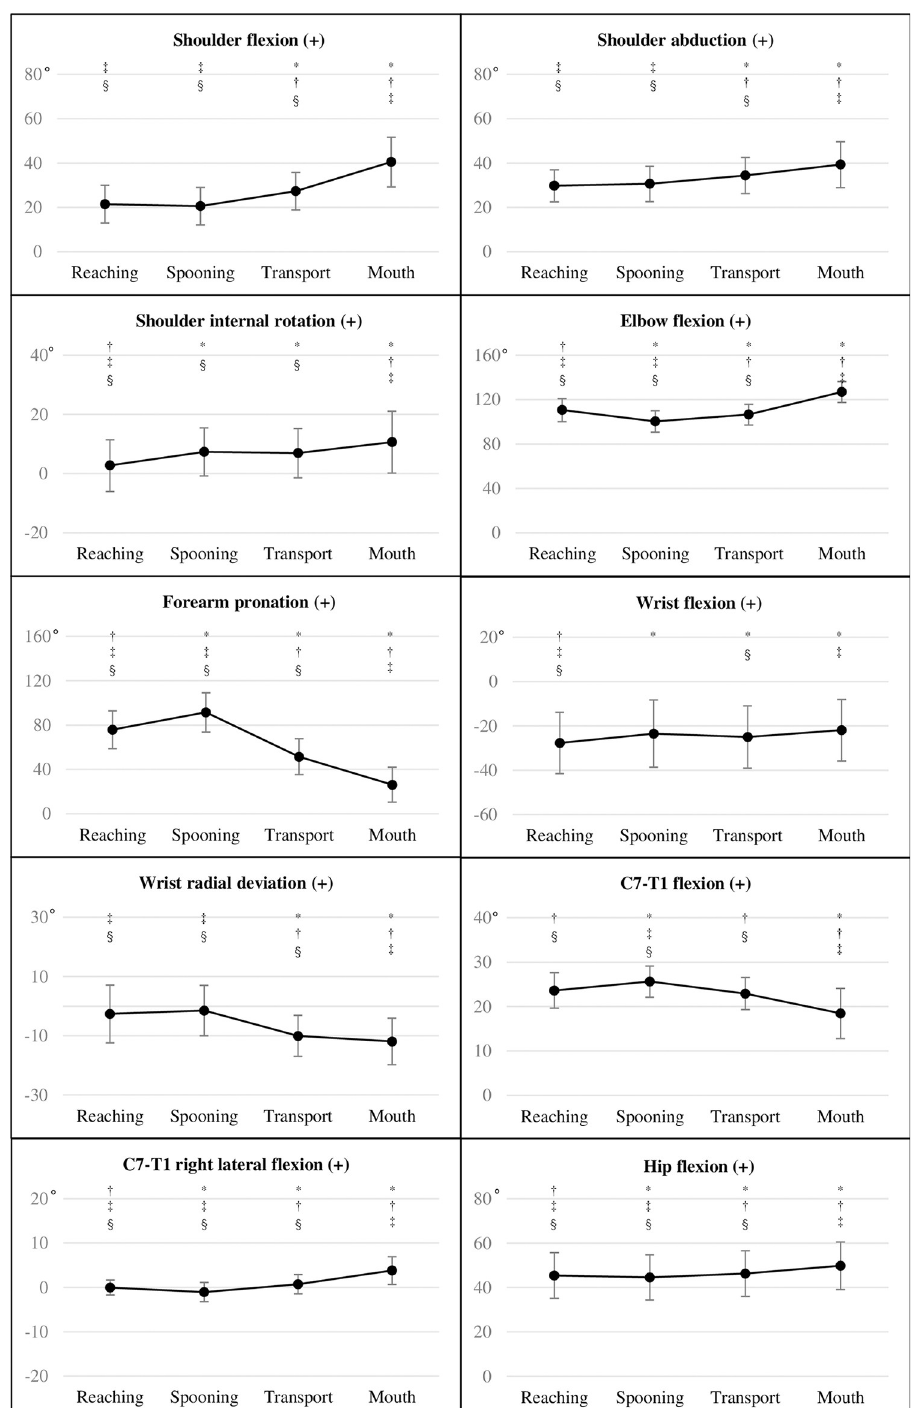
Fig 1. Mean angles in each phase with Bonferroni correction. Eating phases are shown on the horizontal axis. � , significant difference (p < 0.008) compared to the reaching phase; † , significant difference (p < 0.008) compared to the spooning phase; ‡ , significant difference (p < 0.008) compared to the transport phase; § , significant difference (p < 0.008) compared to the mouth phase.